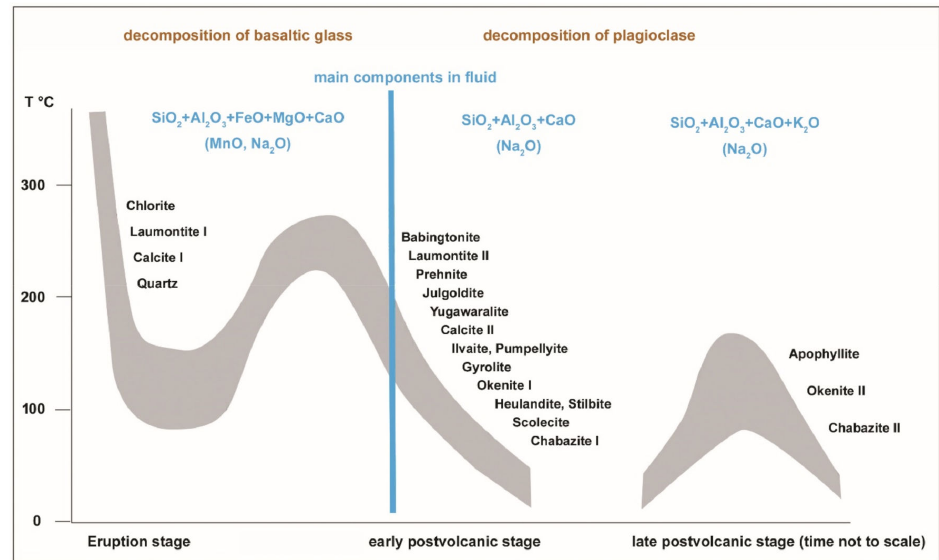
Figure 10. Estimated theoretical model of mineral formation in the pillowed basalt on Salsette Islands: During the eruption stage, interaction of hot lava with water resulted in extensive alteration and formation of chlorite, laumontite I, calcite I, and quartz. After a short period of more or less cooling down, reheating in an early postvolcanic stage up to ca. 300 ◦ C was again followed by successive cooling and temperature controlled precipitation, beginning with minerals of prehnite-pumellyite facies and followed by zeolites. In a later postvolcanic stage several million years after eruption, formation of apophyllite, okenite II, and chabazite II occurred at significantly lower